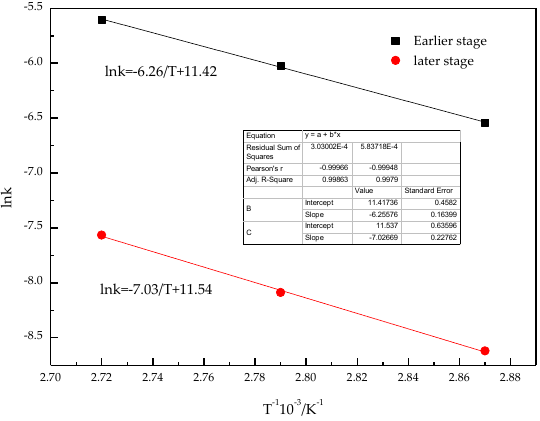
Figure 8. Arrhenius plot of SiO 2 leaching kinetics in the enhanced desilication process. According to the Arrhenius equation ln k = ln A − E a/R T , Plot ln k to 1/ T , as exhibited in Figure 8, both of the two stages have a good linear relationship. Calculated based on the slope of the fitted curve, the earlier stage ’s activation energy is 52.05 kJ/mol, the later stage ’s activation energy is 58.45 kJ/mol.